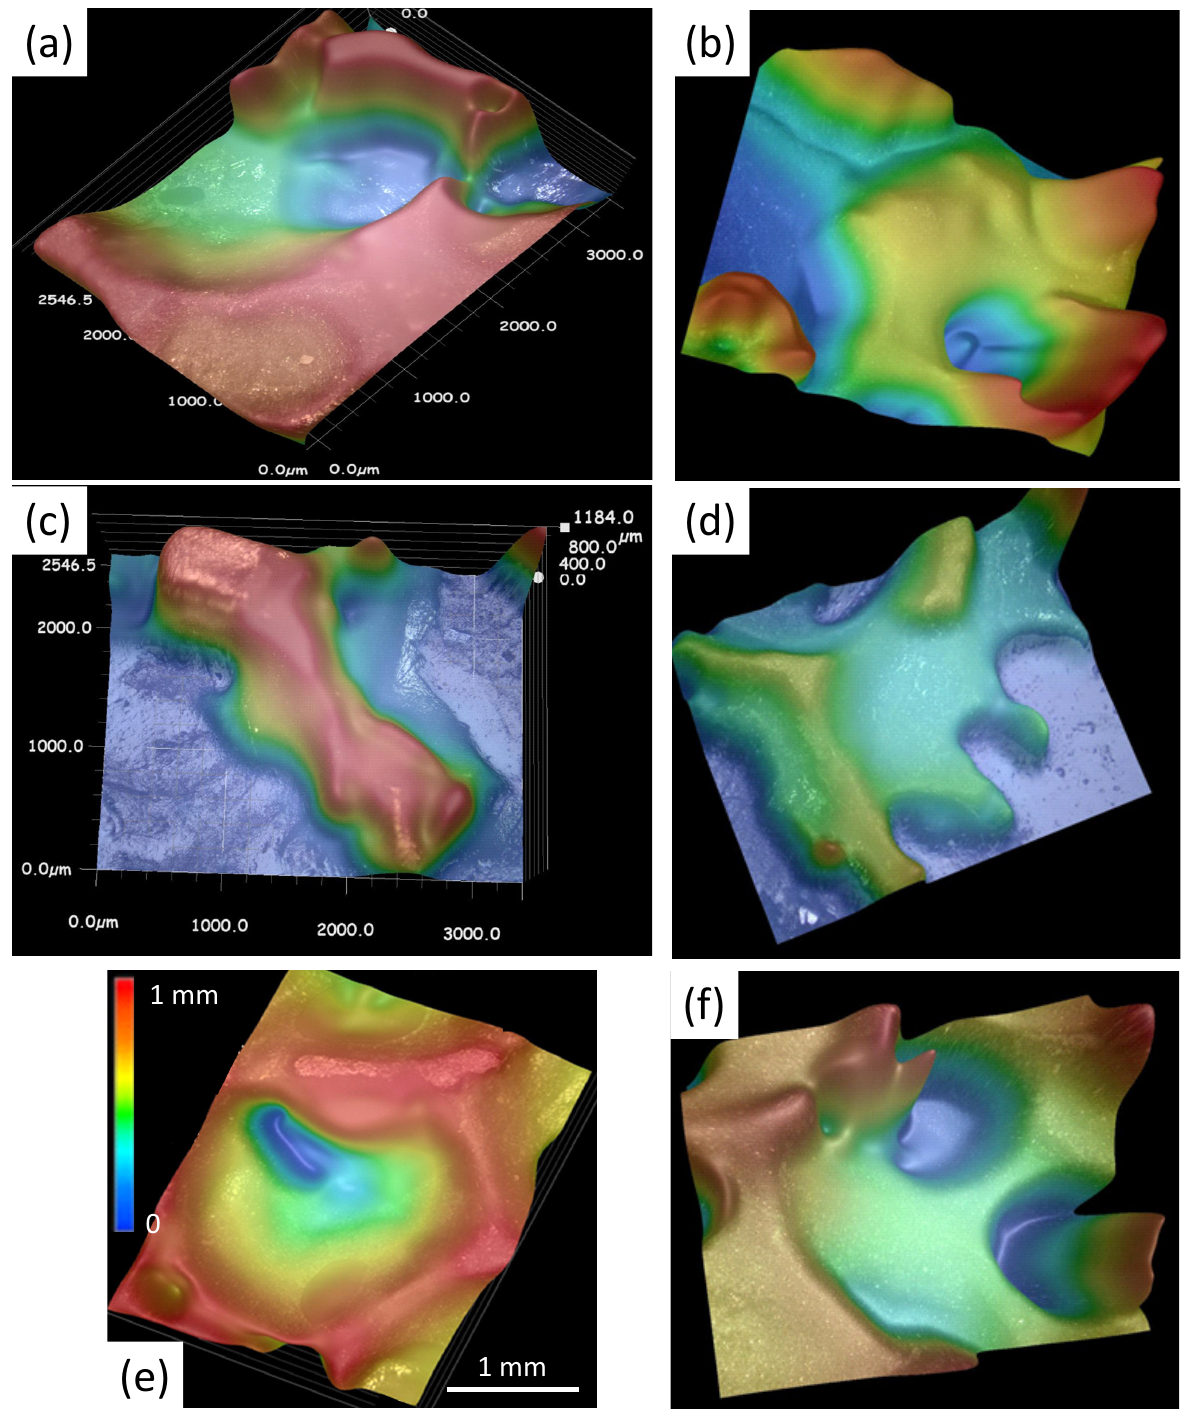
Figure 6. ( a – f ) Digitally processed images of foam windows, struts and ligaments in various positions within the bulk foam sample. Images ( a , c ) show the calibrated size data, and ( e ) gives the extracted values for x and the color code for z . These images are the base for the analysis presented in Figure 7